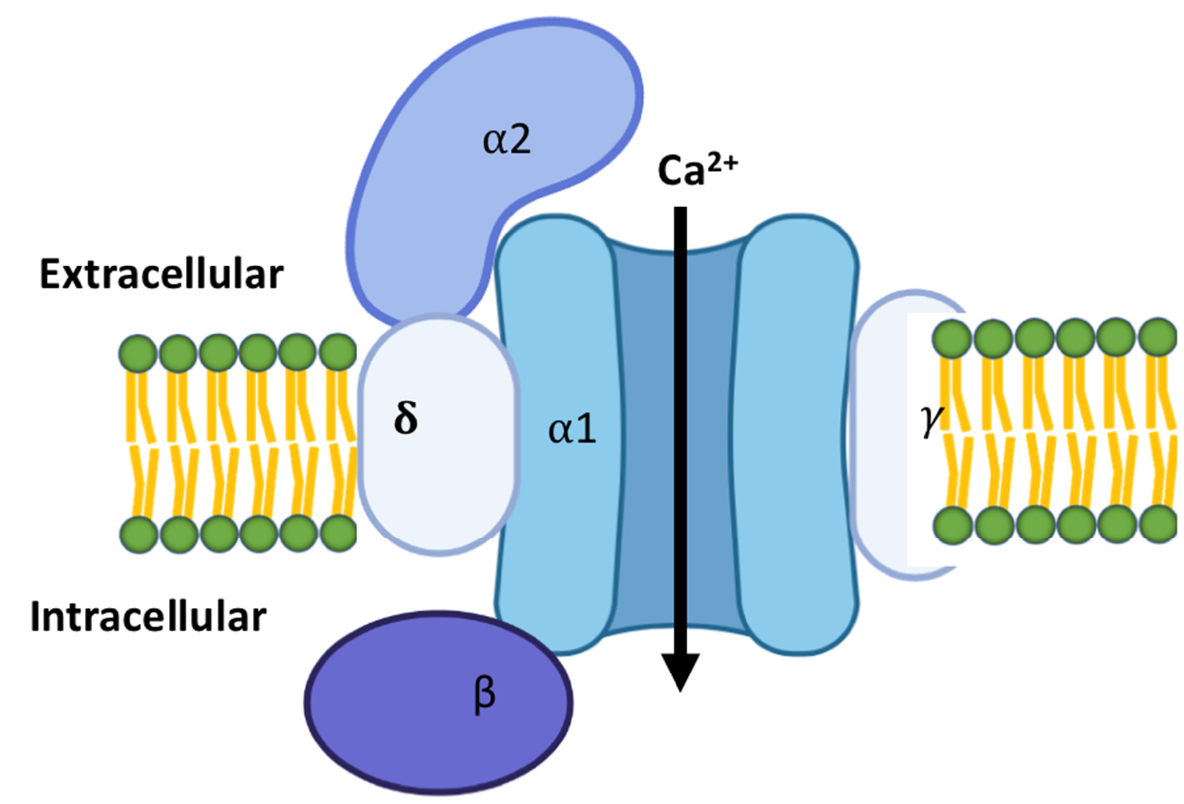
Figure 1. Schematic representation of the calcium channels: Calcium channels are a complex of 4–5 distinct subunits. The α 1 subunit is the largest subunit and it incorporates the pore region, the voltage sensor and gating apparatus, several channel regulation sites by second messengers, drugs, and toxins. There is an intracellular β subunit, a transmembrane, α 2 δ subunit complex, and a transmembrane γ subunit.